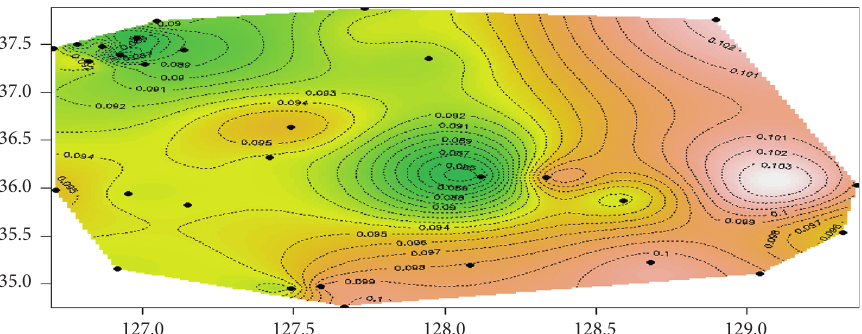
Figure 8: Interpolations of the 25 years’ return levels for extreme ozone concentrations in 29 air monitoring sites versus longitude ( x -axis) and latitude ( y -axis) in South